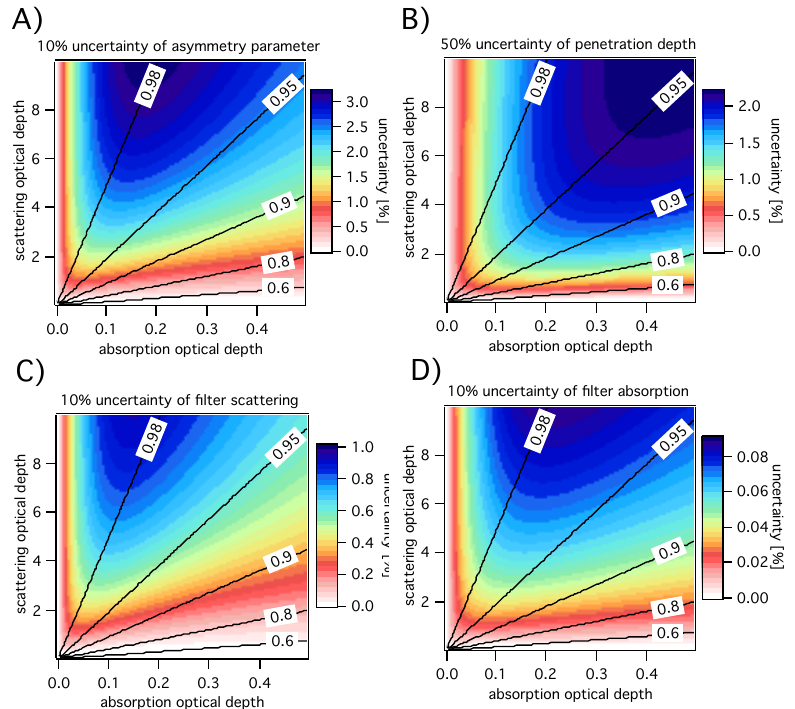
Figure 11. Relative uncertainties in the relative optical depth caused by uncertainties in (a) filter asymmetry parameter; (b) particle layer thickness; and (c) and (d) filter scattering and absorption optical depth, respectively. Uncertainties were calculated for ranges of particle scattering and absorption optical depth and for a particle asymmetry parameter of 0.7. The solid lines indicate constant single-scattering